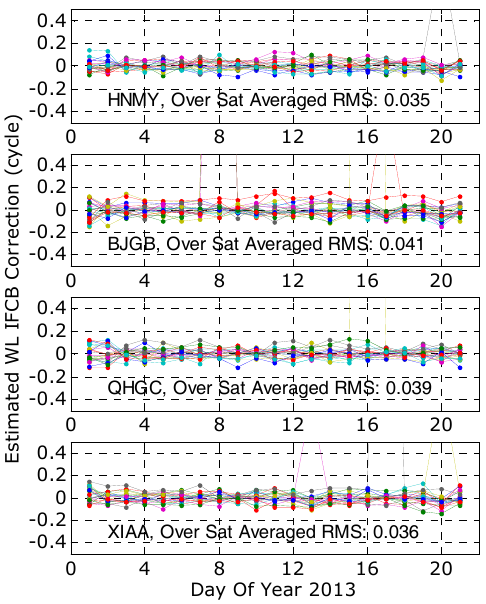
Figure 5. Stability of daily WL IFCB estimates of all 24 GLONASS satellites for four representative stations. Different color represents different satellites. Outliers correspond to there being no IFCB estimate for this satellite on this day.